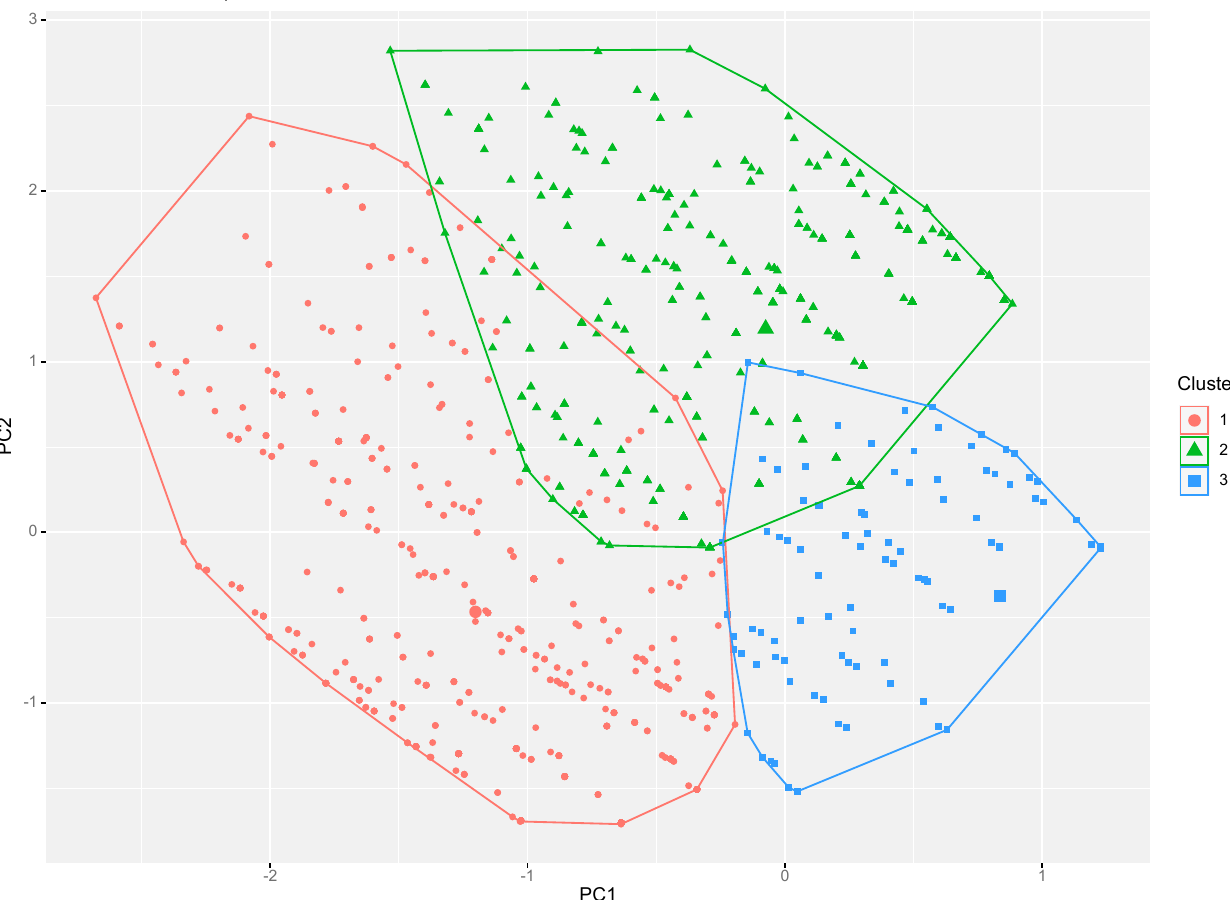
Figure 2. Graphical representations of reports clusters identified by means of k-means cluster analysis on the identified principal components.